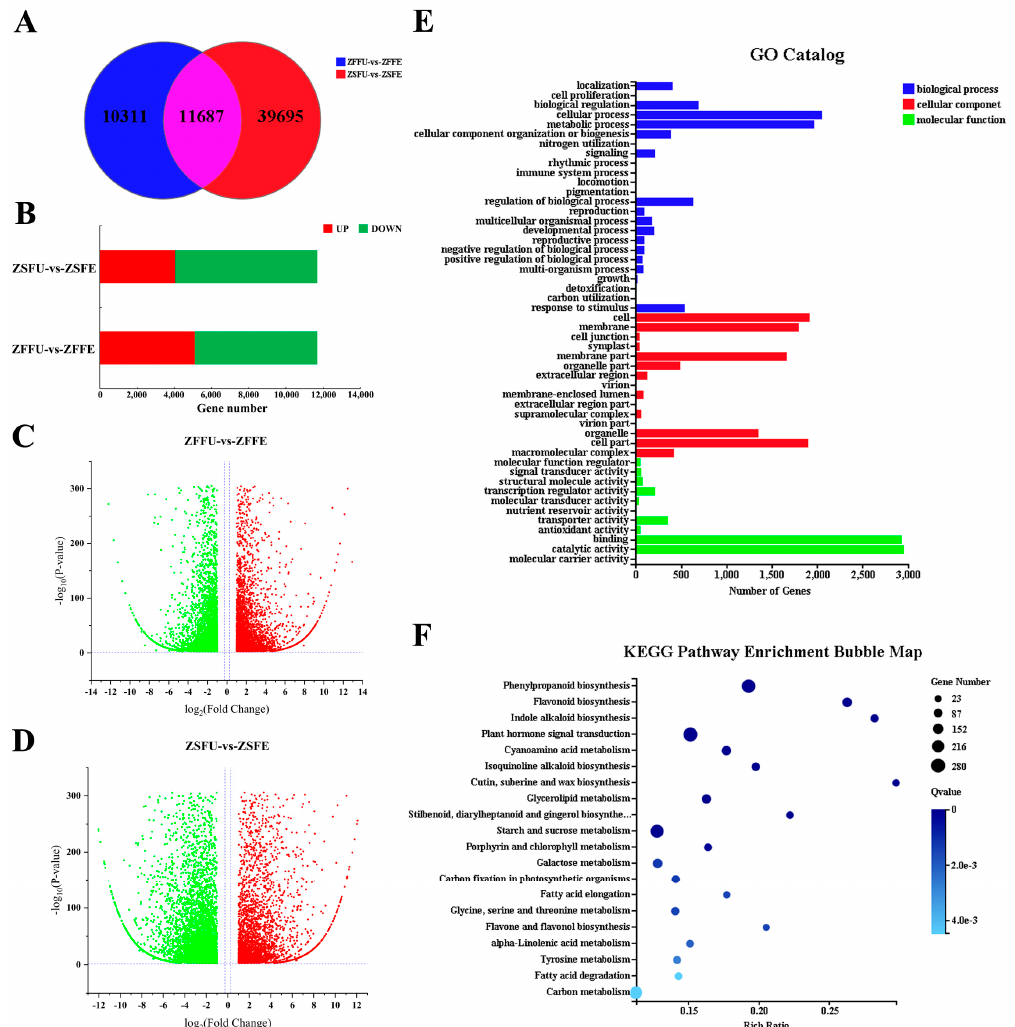
Figure 3. Number and function analysis of DEGs. ( A ) The Venn chart of DEGs in contrast groups of ZFFU vs. ZFFE and ZSFU vs. ZSFE; ( B ) up and down statistics of shared DEGs; ( C , D ) the volcanic map of shared DEGs during spring ( C ) and summer ( D ) flowering initiation; ( E , F ) the GO catalog ( E ) and the KEGG pathway enrichment bubble map ( F ) of shared DEGs of spring and summer flowering initiation. ZFFU vs. ZFFE: contrast group of spring flowering initiation; ZSFU vs. ZSFE: contrast group of summer flowering initiation.